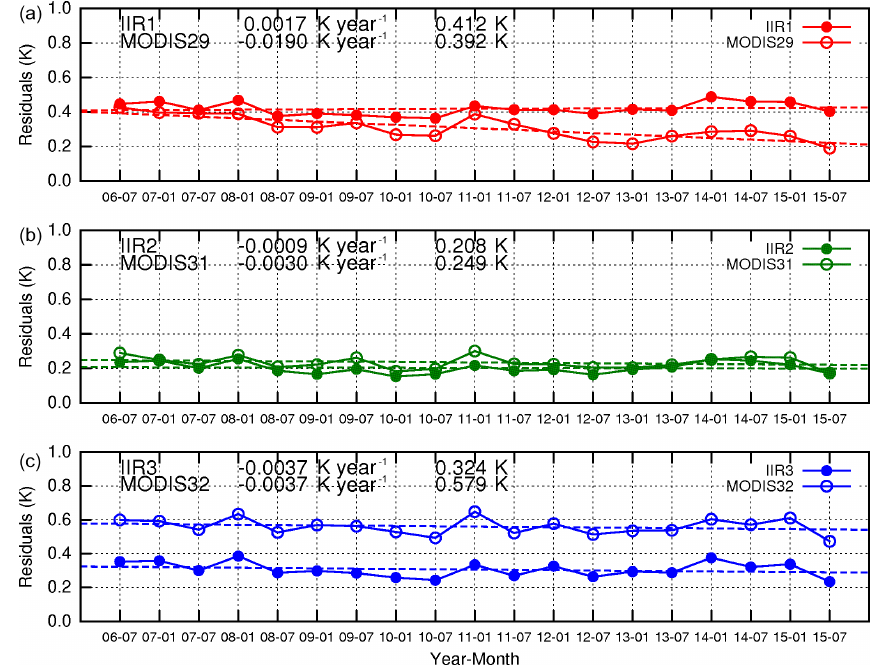
Figure 13. Time series ( x axis: year-month) of residuals ( y -axis units: Kelvin) for the three pairs of IIR and MODIS channels ( a IIR1 and MODIS29 in red, b IIR2 and MODIS31 in green, c IIR3 and MODIS32 in blue, with IIR in full circles and MODIS in open circles) over ocean in the tropics at 30 ◦ S–30 ◦ N, day and night. Superimposed are linear regressions lines with temporal origin at the beginning of the mission. Slopes (in Kyr − 1 ) and intercepts (in K) are given on each